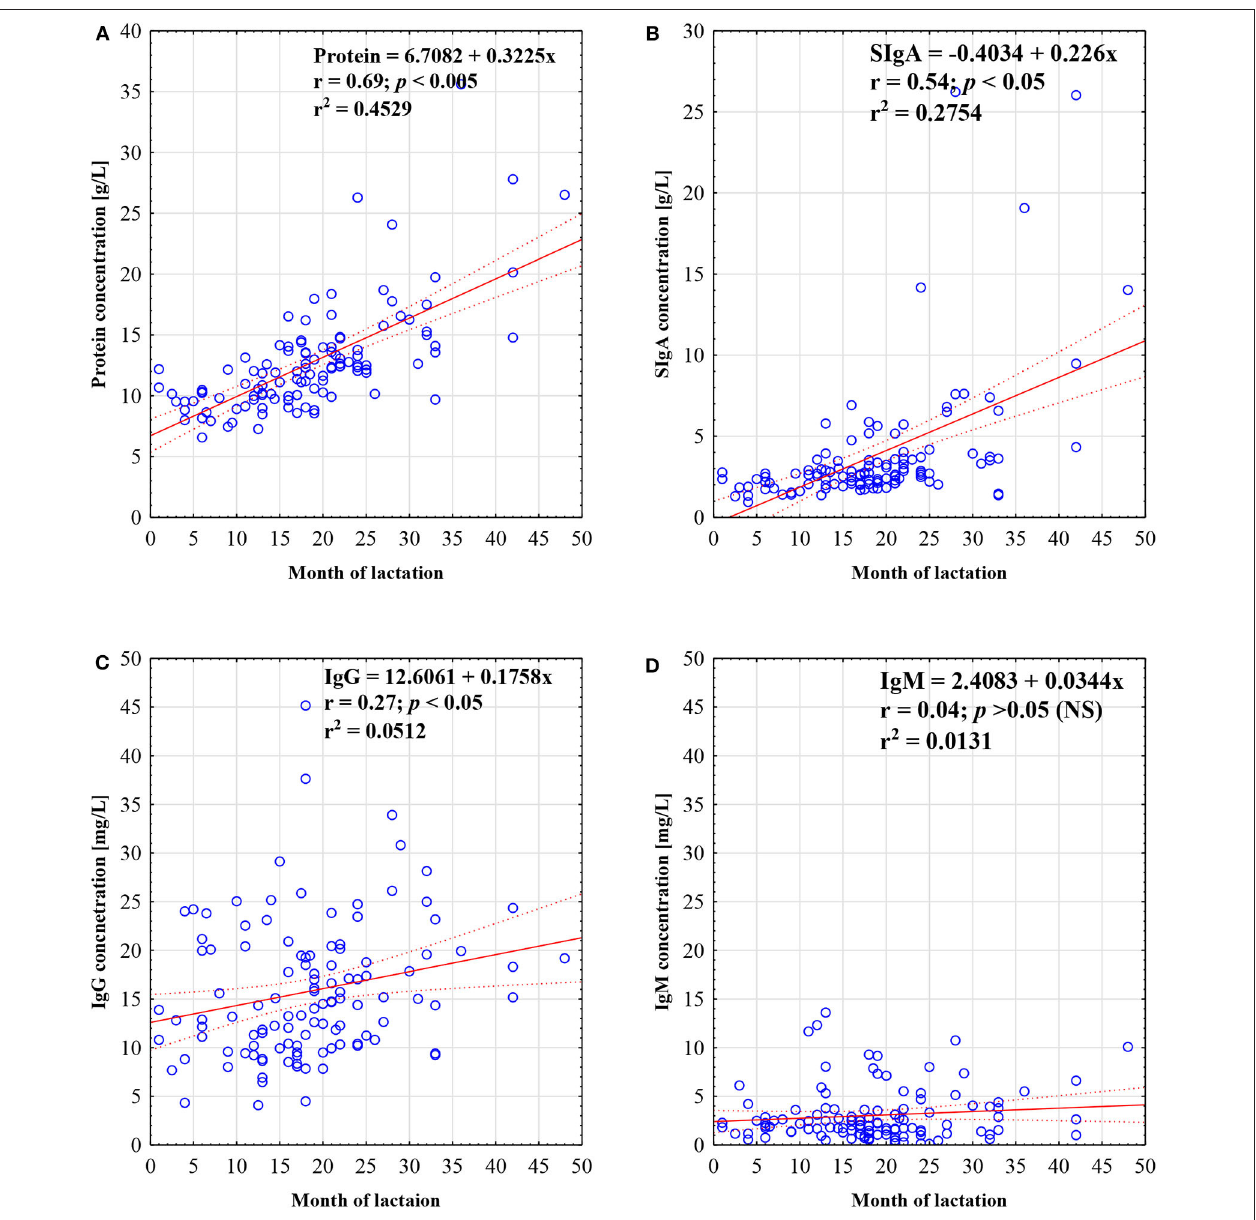
FIGURE 1 | Concentration of protein (A) , SIgA (B) , IgG (C) , and IgM (D) in skim milk in prolonged lactation up to 48 months. A solid line indicates linear regression, and 95% confidence intervals are shown by dotted lines; blue circles refer to individual samples. The correlation coefficient ( r ) was calculated according to Spearman, and a p -value lower than 0.05 was regarded as significant. The r -square value is the square of the correlation coefficient. NS, not significant.